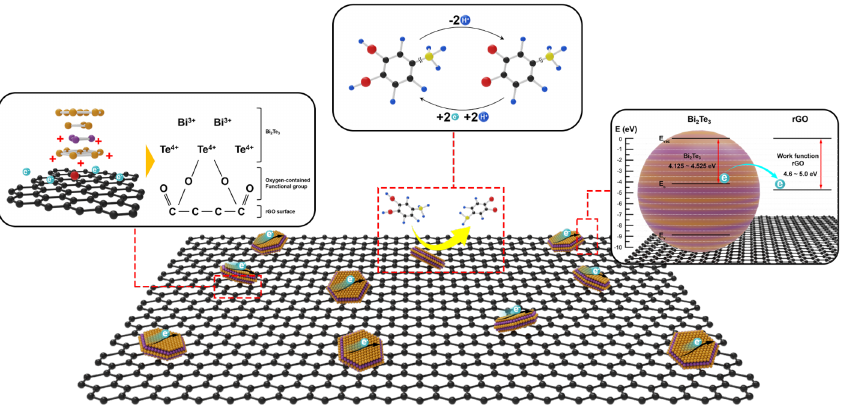
Figure 9. Schematic illustration of the charge transfer in the BT/rGO nanocomposite for the electro- chemical sensing of dopamine.